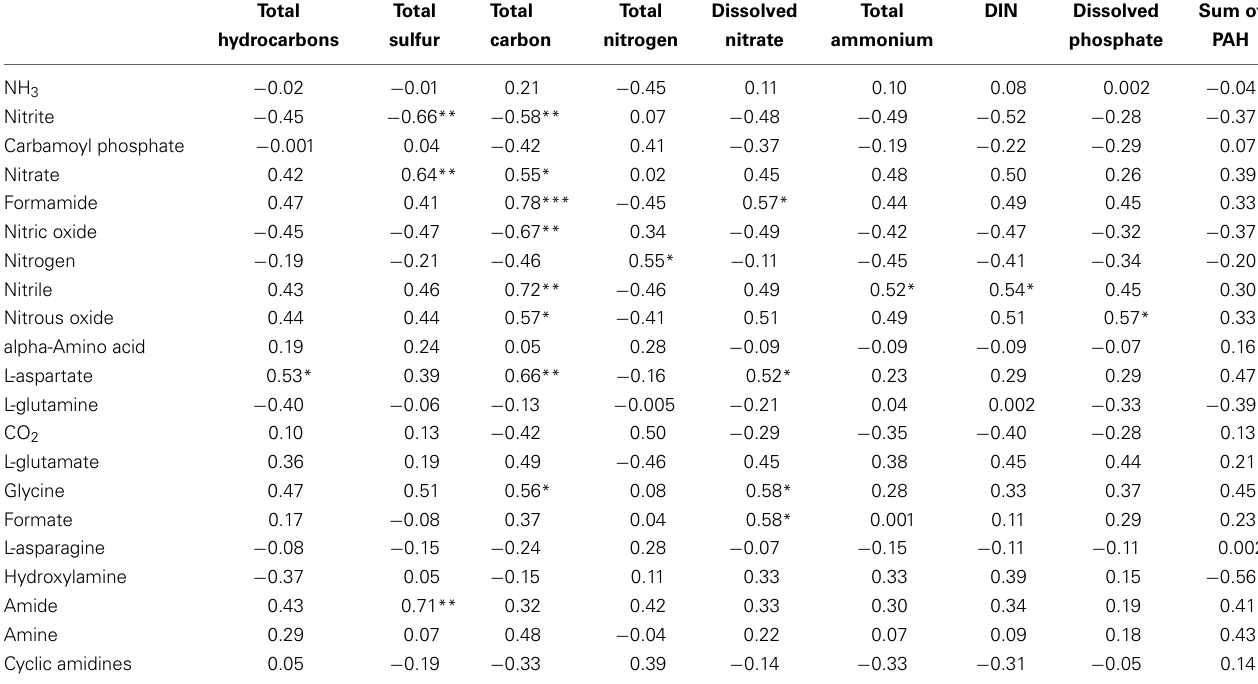
Table 3 | Pearson correlations of metadata from 14 metagenome samples (Mason et al., 2014) with predicted relative nitrogen metabolite PRMT scores and their associated p